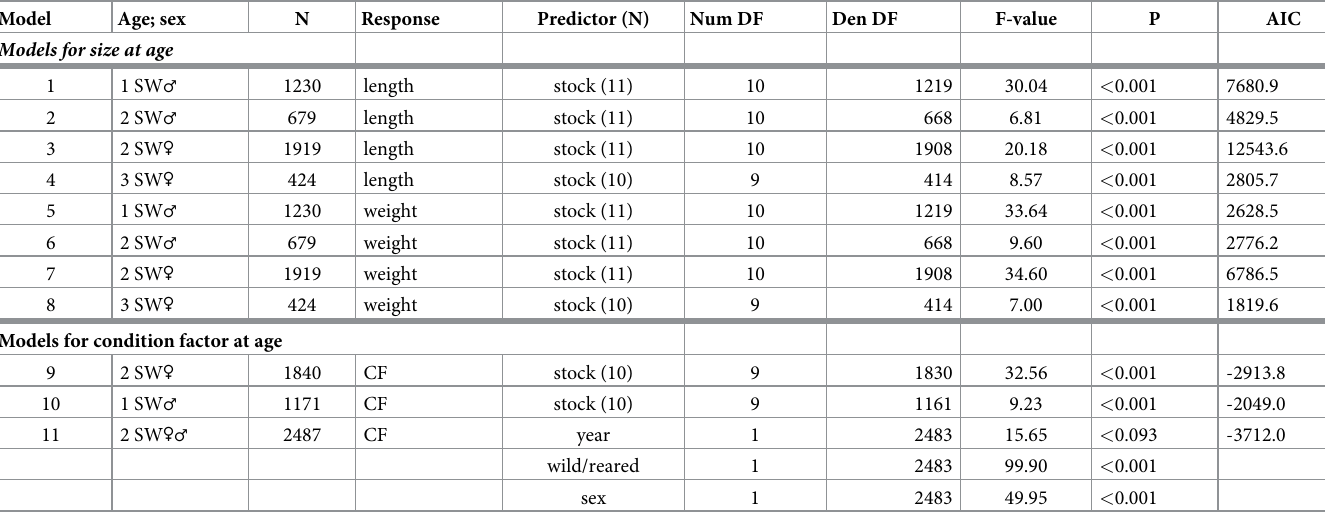
Table 2. Models used for analyzing catch size-at-age of Atlantic salmon spawners from different river